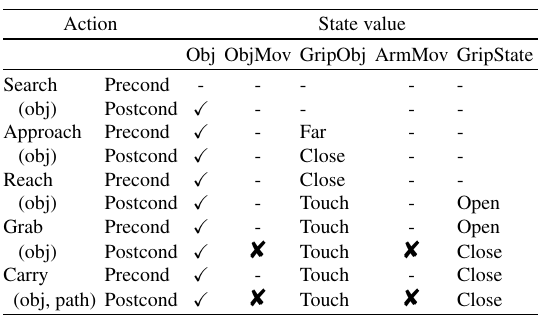
Table 2 State values for the actions used in the pick and drop task Action State